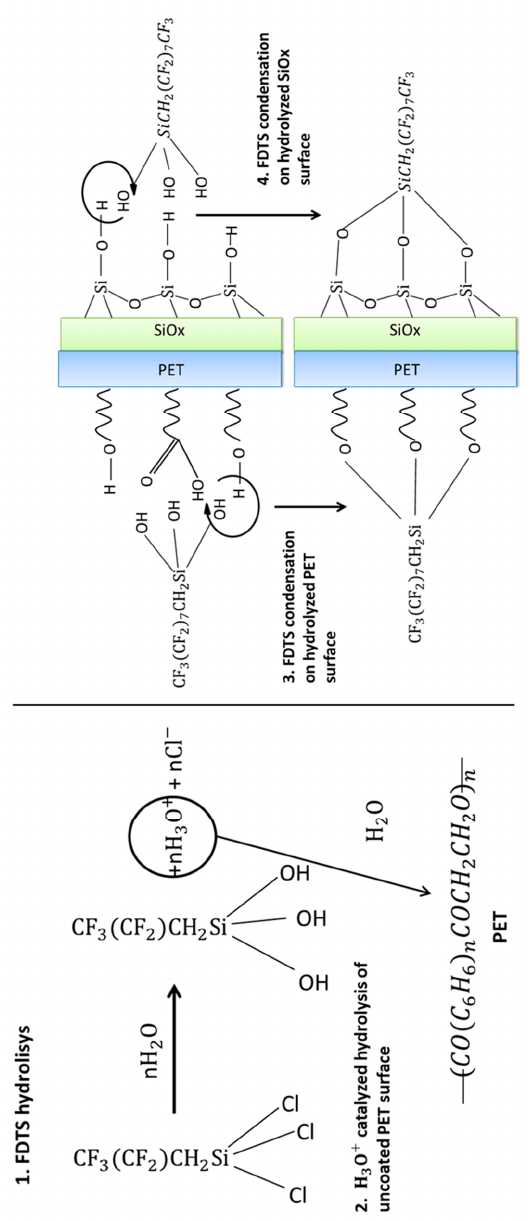
Figure 7. Sketch of the possible reaction mechanism between the FDTS and the uncoated PET layer of the PET-SiOx film.